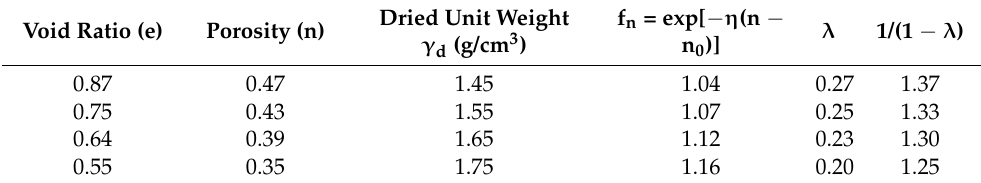
Table A1. Water retention curve parameters for Barcelona silty clay.